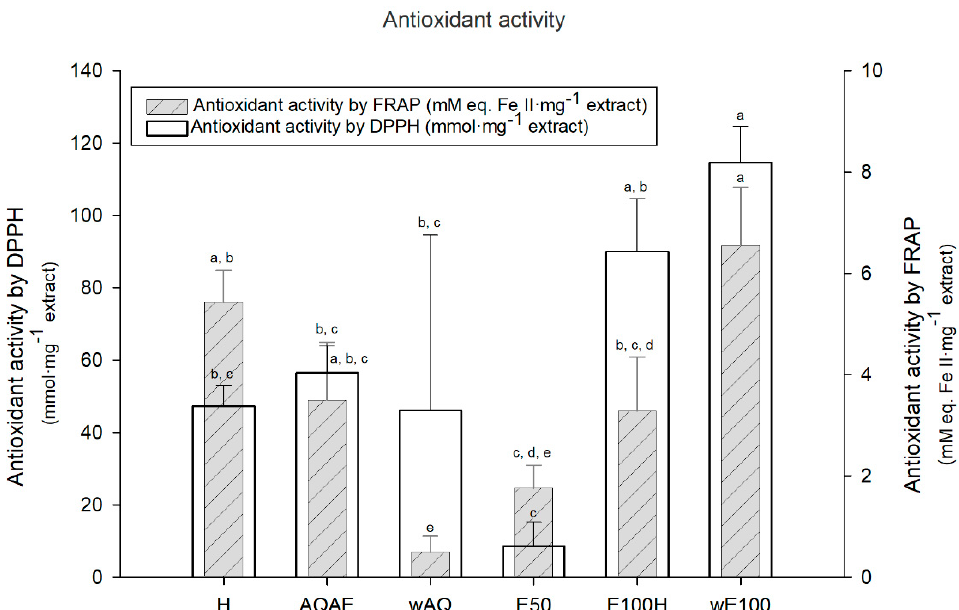
Figure 2. Antioxidant activity was evaluated by two different methods, Diphenyl-1-picrylhydrazyl (DPPH) and Ferric Reducing Antioxidant Power (FRAP) assay, of the six crude extracts of Undaria pinnatifida produced in optimized extraction. The results represent the mean ± SD of triplicate experiments. For each of the assays, the differences between extracts were evaluated using Tukey’s test. Bars with the same letters do not have statistically significant differences ( p > 0.05). Table 2. Antimicrobial activity of all the six extracts of Undaria pinnatifida at 1.5 mg · mL − 1 by broth microdilution assay against Staphylococcus aureus , Pseudomonas aeruginosa , Klebsiella pneumoniae , Escherichia coli , and Proteus mirabilis . Inhibition control was obtained using ciprofloxacin (CP). The results represent the mean ± SD of triplicate experiments. For each of the species, the differences between extracts were evaluated using Tukey’s test. Values with the same superscript letters do not have statistically significant differences ( p >